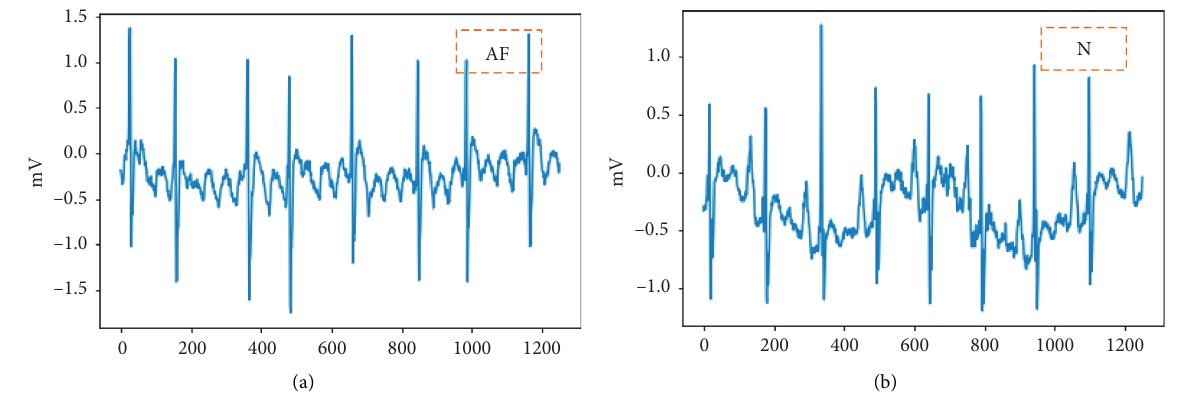
Figure 2: Comparison of AF signal and N